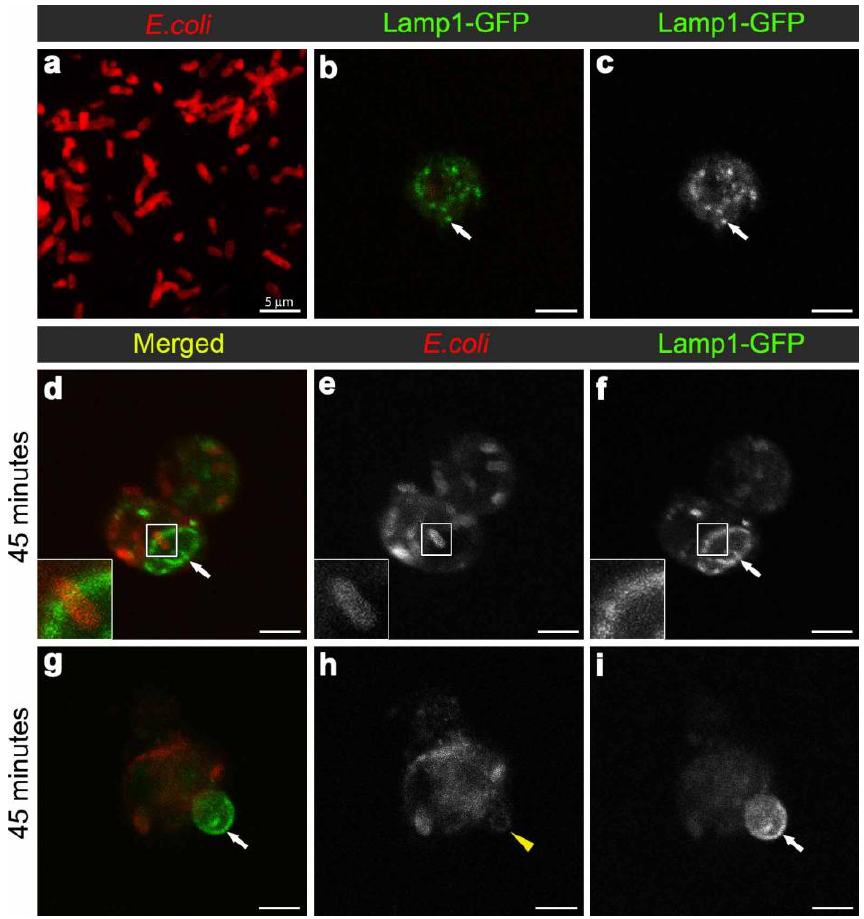
Figure 4. Confocal micrograph of intact E. coli (red in (a) , replicated from Figure 2a, for scaling purposes to illustrate the size and rod-shape of free E. coli ). Confocal micrographs of Lamp1-GFP positive vesicles (expressed using CG-GAL4>Lamp1-GFP ): in uninfected wild-type hemocytes as green (b) and grayscale (c) and depicted by arrows; and in hemocytes 45 minutes after infection as green (d, g) and grayscale (f, i) and depicted by arrows; with E. coli visualized as red (d, g) , and grayscale (e, h) . Inset in (d-f) depicts intact E. coli entering enlarged Lamp1-GFP compartment, framed in the main panels. Arrows in (g, i) depict Lamp1-GFP-positive bud in wild-type hemocyte, containing a